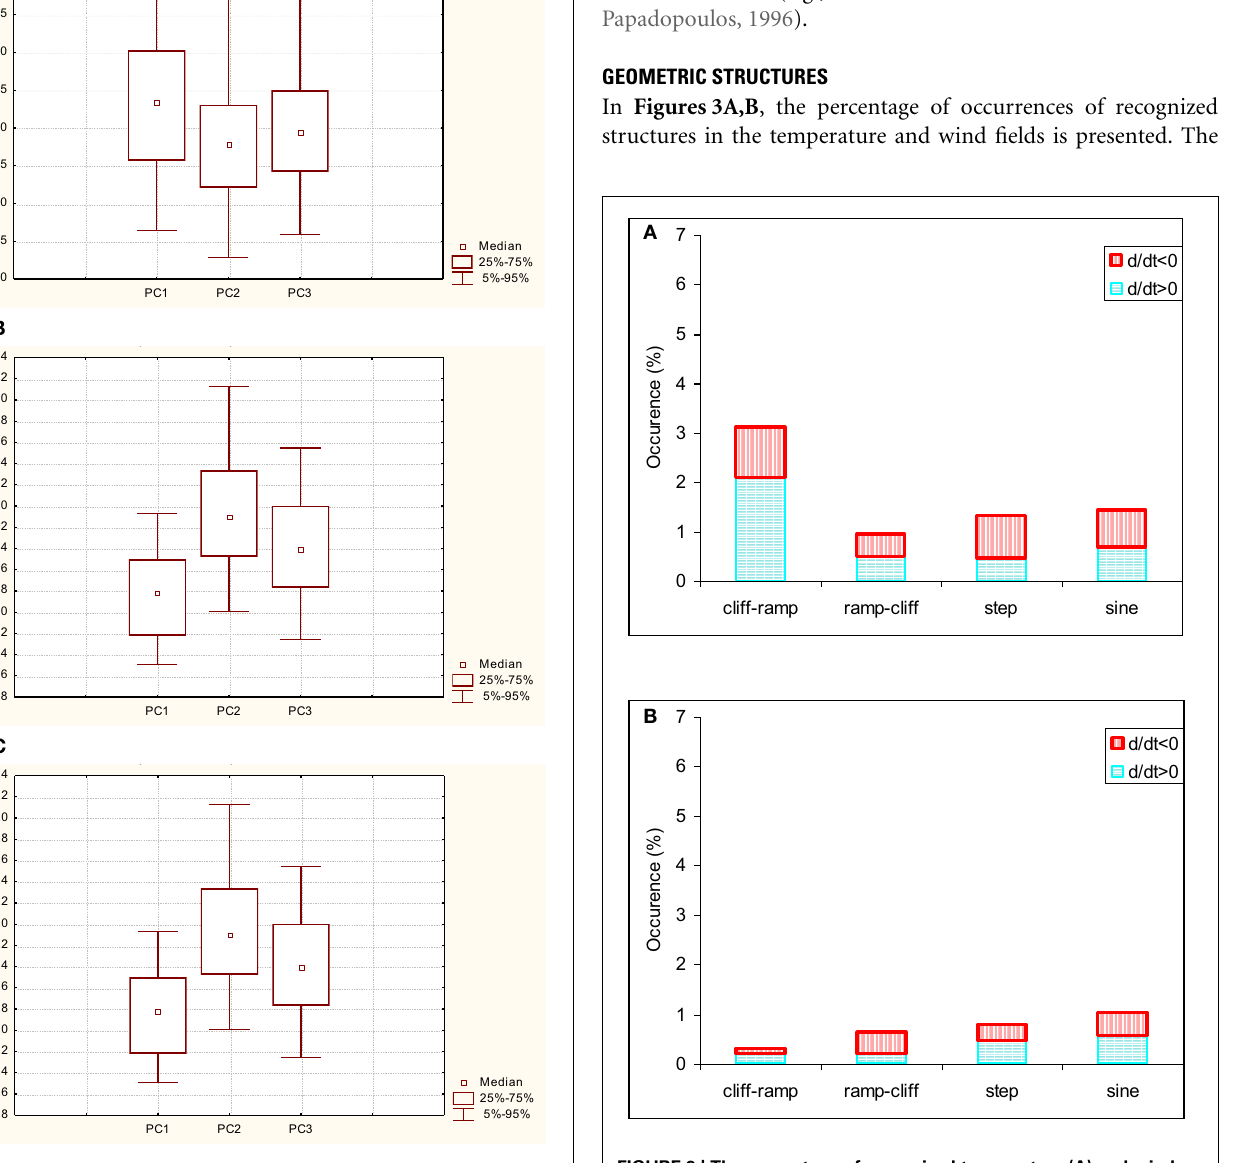
FIGURE 2 | Box-plot of the PC scores under recirculation conditions (A) stagnation conditions (B) and ventilation conditions (C).